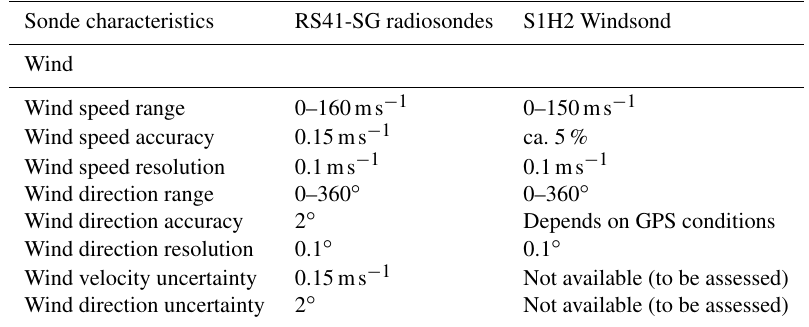
Table 5. Sonde wind measurement characteristics (based on Table 7 from Vaisala, 2014; SparvEmbedded,